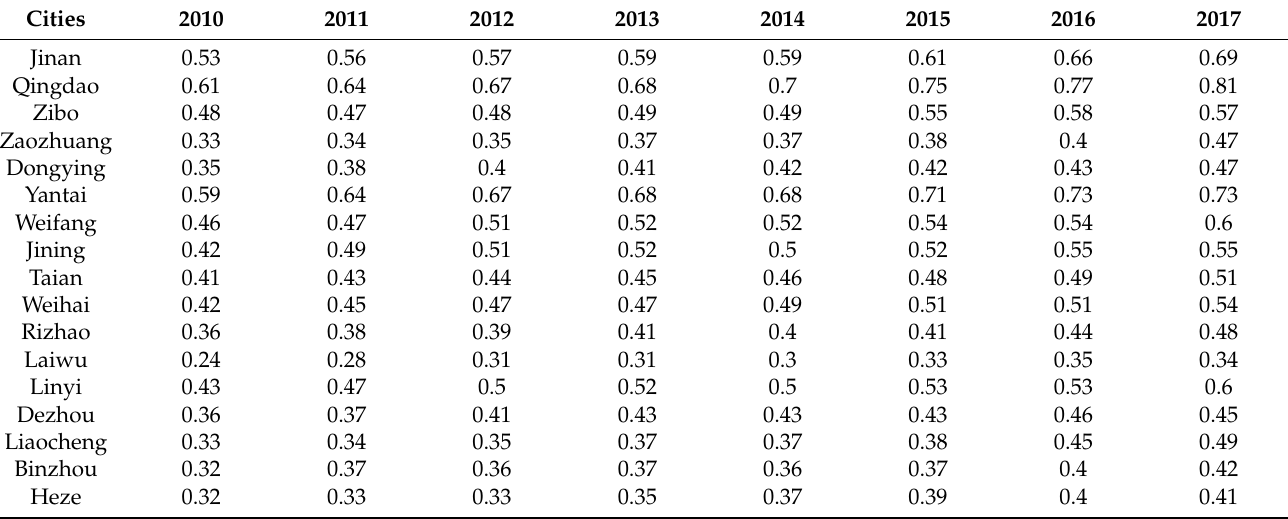
Table 4. Coupling coordination degree of TEE of cities in Shandong